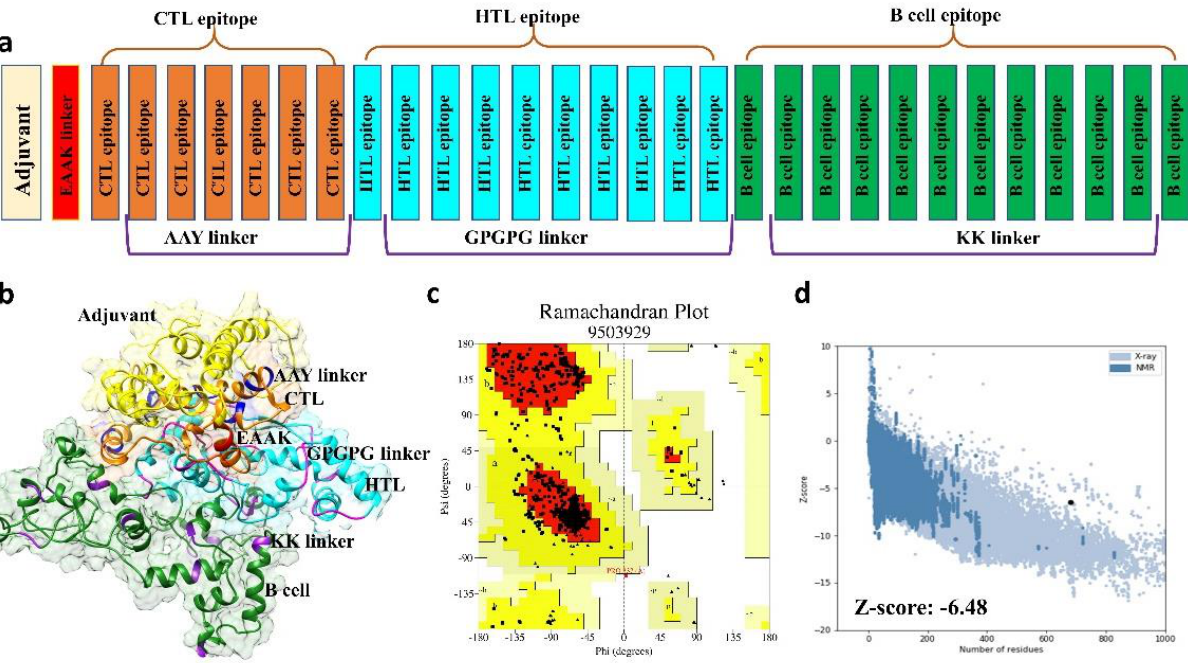
Figure 2. ( a ) Structure of the final multi-epitope vaccine construct and validation of the 3D homology model. ( b ) 3D structure of the vaccine construct provided after homology modeling. CTL, HTL, and B cell epitopes along with linkers are depicted. ( c ) Structure validation of the multi-epitope vaccine by Ramachandran plot. ( d ) ProSA 3D structure validation illustrating Z- score (−6.48).